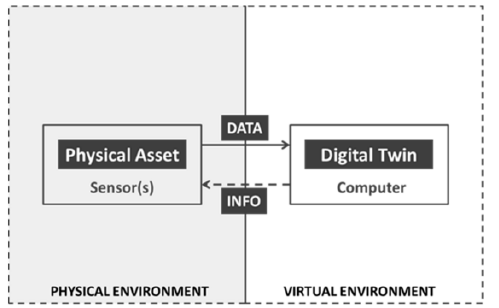
Figure 13. Conceptual representation of a DT and its association with a physical asset [104].